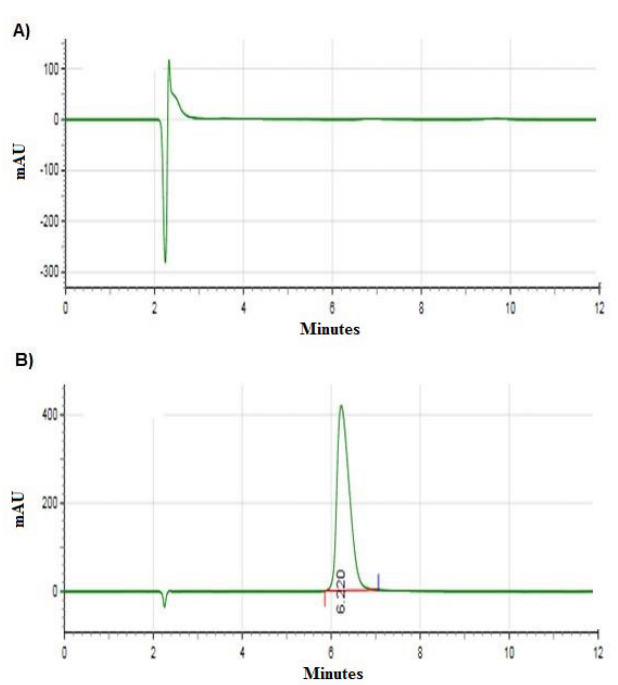
FIGURE 2 - Representative chromatograms of A) Blank and B) Sample containing trimethobenzamide.